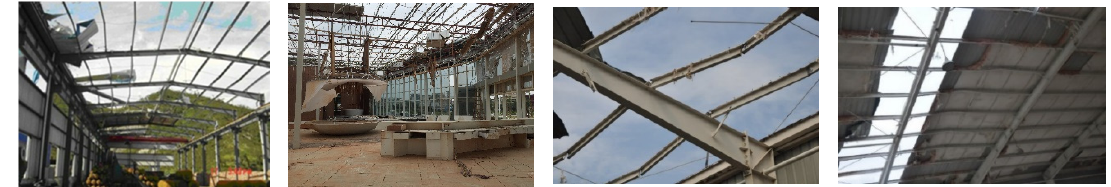
Figure 2. Buckling of Purlins under the wind uplift loadings.